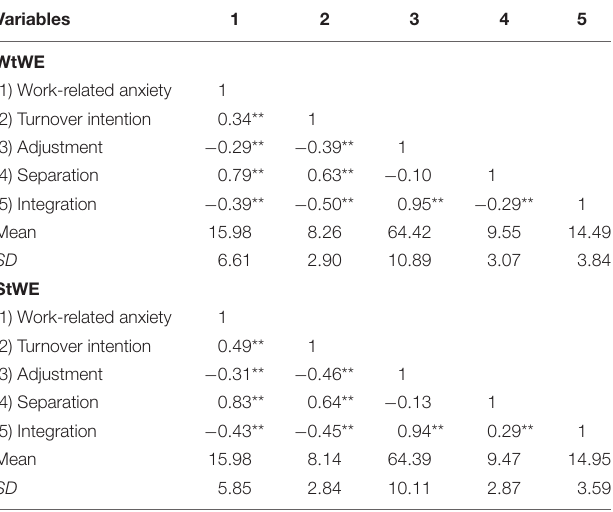
TABLE 8 | Descriptive statistics and intercorrelations ( N = 123).